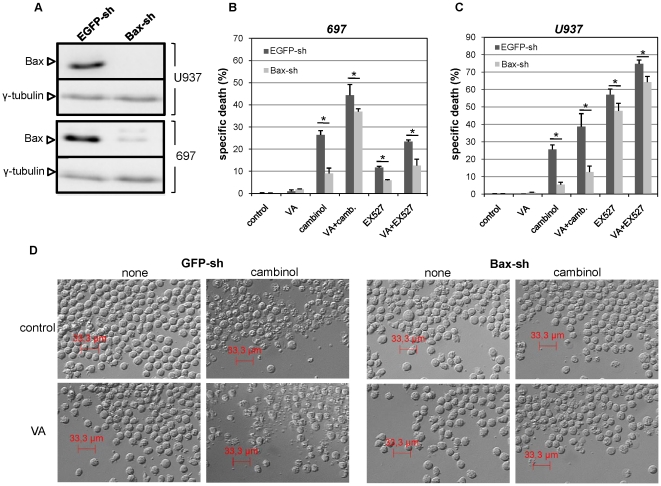
Bax silencing reduces sirtuin inhibitor activity in leukemia cells.A, B, U937 and 697 cells were transduced to either express an anti-EGFP shRNA (EGFP-sh) or a validated anti-Bax shRNA (Bax-sh). Thereafter cells were used for cell lysate preparation and Bax and γ-tubulin were detected by immunoblotting. B, EGFP-sh or Bax-sh 697 cells were incubated with or without 100 µg/ml VA, 75 µM EX527, 50 µM cambinol, or their combinations. Viability was assessed 36 h later by PI staining and flow cytometry. C, D, EGFP-sh or Bax-sh U937 cells were incubated with or without 100 µg/ml VA, 150 µM EX527, 100 µM cambinol, or their combinations. 36 h later, cells were imaged by light microscopy (D) and cell death was determined by flow cytometric quantification of PI-positive cells (C). A, D, one representative experiment out of three is presented. B, C, Results are means ± SD of three separate experiments. *: p<0.05.